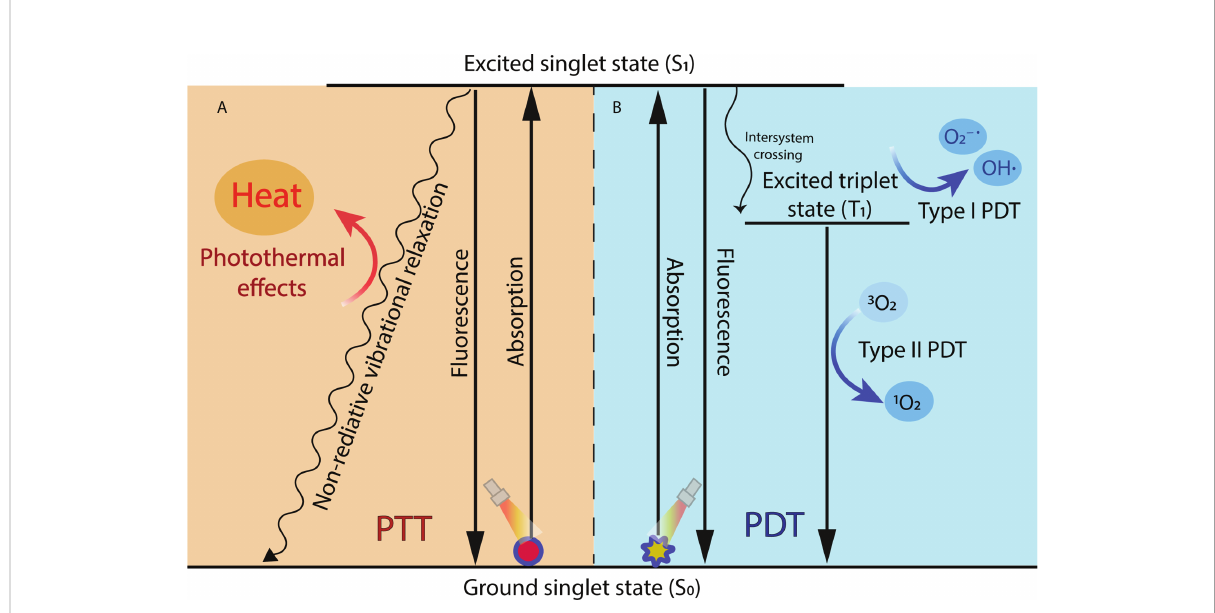
FIGURE 2 Mechanisms of photodynamic reaction and photothermal effect during PDT and PTT. (A) In PTT, when excited singlet state photothermal agents return to the ground state, they undergo nonradiative vibrational relaxation, increasing the surrounding microenvironment temperature and causing cell death. (B) In PDT, the excited singlet state of the photosensitizer transforms to a more stable excited T 1 through intersystem crossing and then fi nally generates ROS through type I reaction or type II